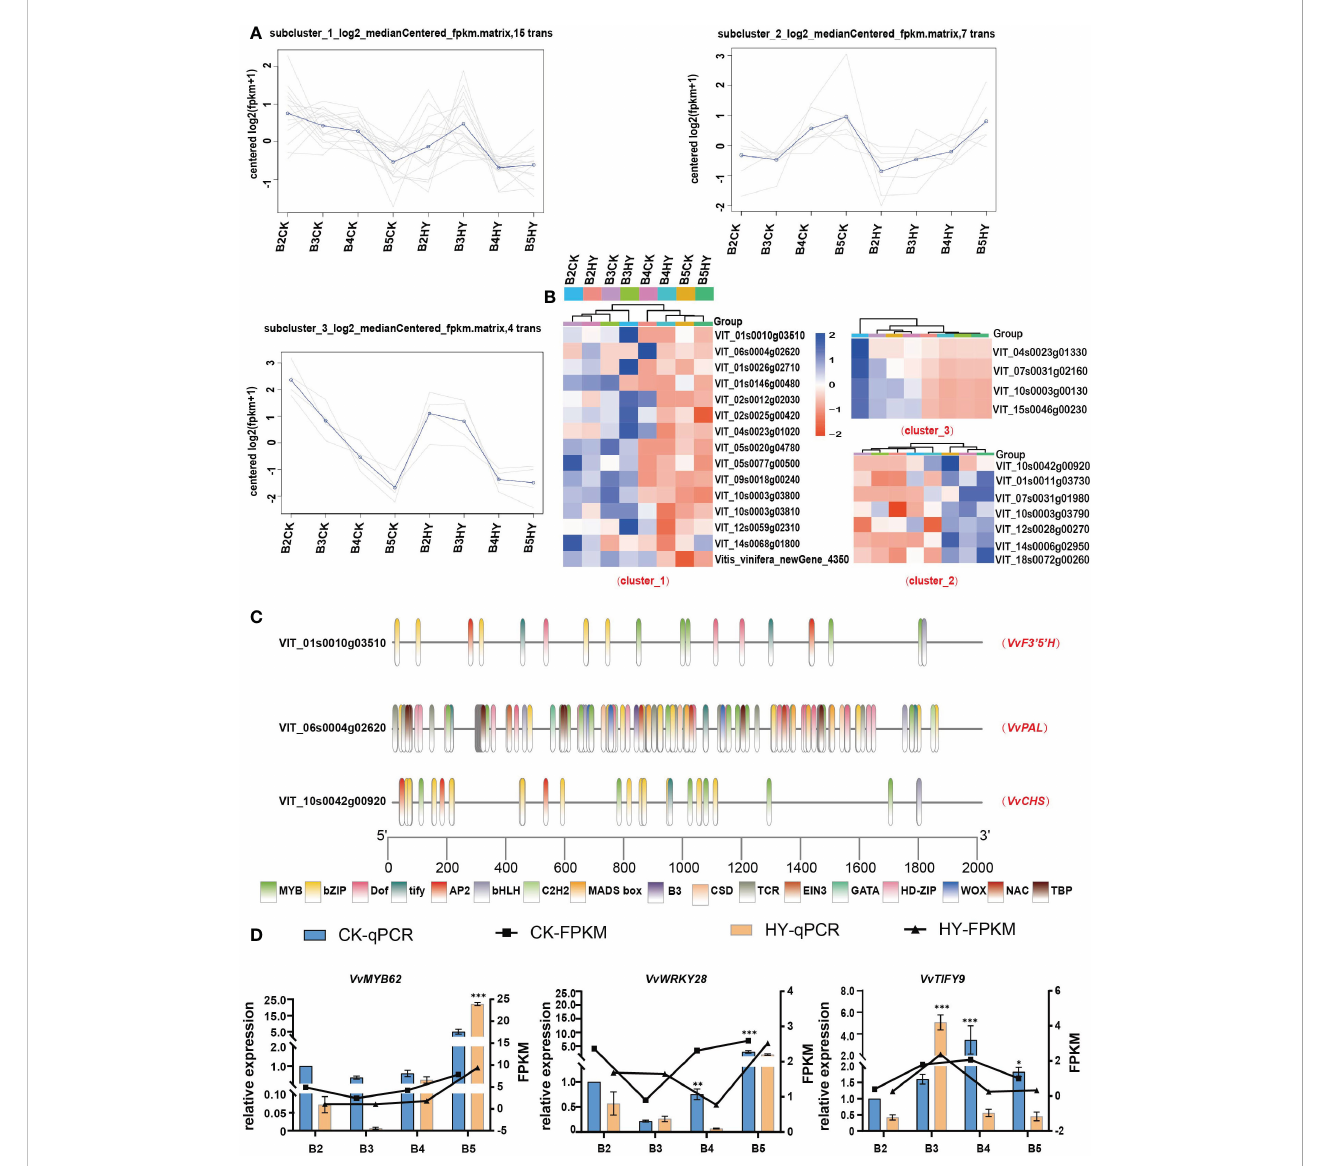
FIGURE 6 The screening and identi fi cation of transcription factors. (A) Co-expression trend analysis of transcription factors and enzymes. (B) Heat maps show the expression levels of selected transcription factors. (C) Analysis of promoter cis-acting elements. (D) RT-qPCR show the expression of transcription